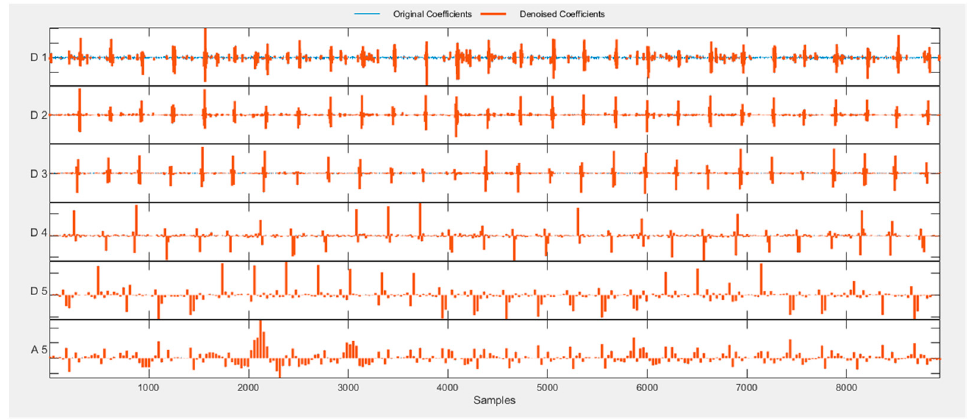
Figure 9. An example of a five-level decomposition of an ECG signal based on a symlet. The results from Table 2 were obtained by simulating the proposed system using various symlet. Each value of the table is the result of training the proposed system for neural network determination of atrial fibrillation based on LSTM with signal preprocessing using different coefficients of symlet. The best learning result was obtained using a five-coefficient symlet. Table 2. Simulation of the proposed method using a wavelet symlet with different coefficients.